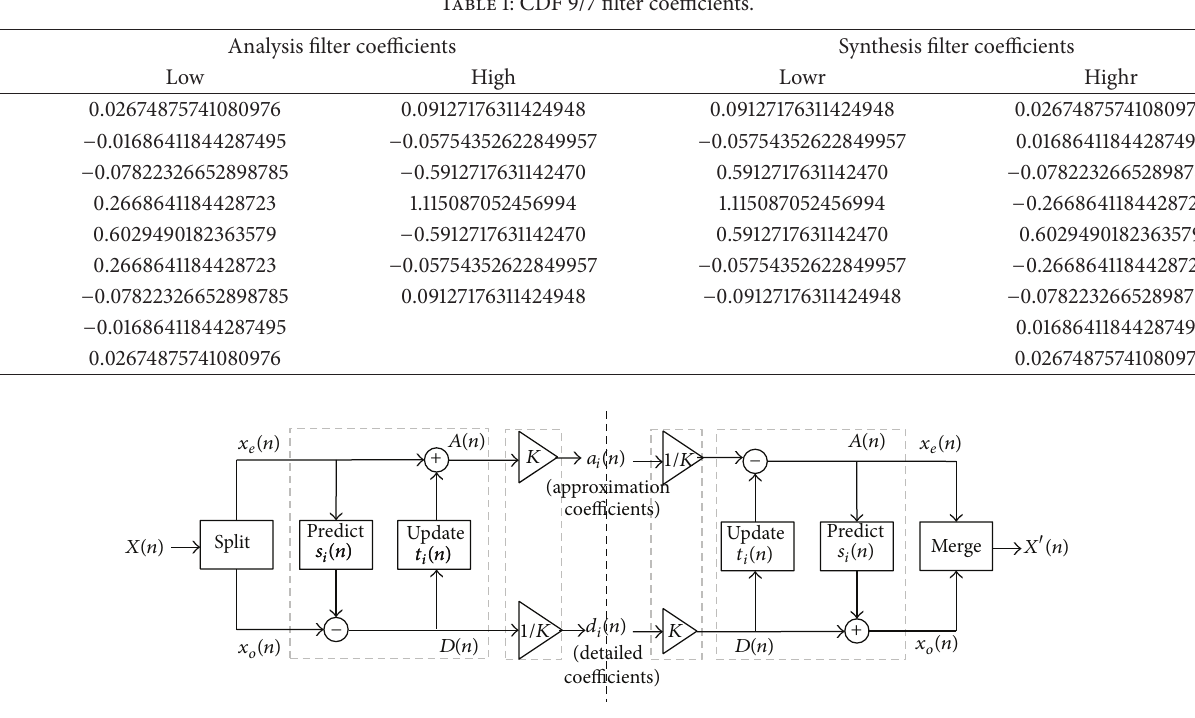
Figure 2: Discrete wavelet transforms using lifting